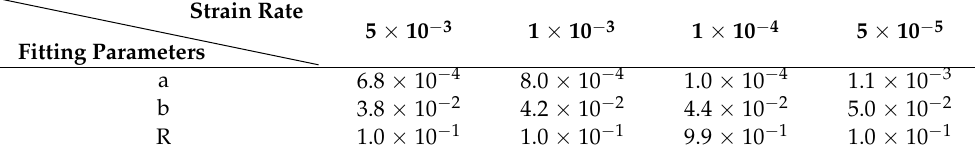
Table 1. Fitting parameters of stress–strain curves.